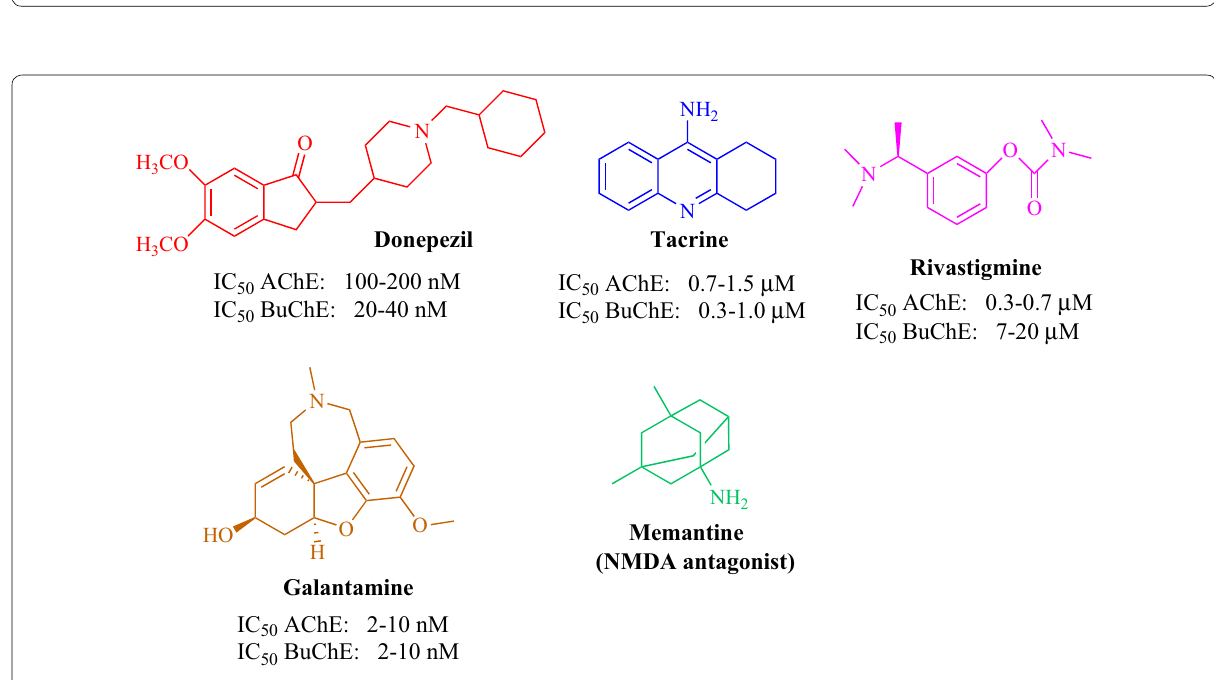
Fig. 35 Interaction of compound C40 docked into the binding site of AChE. The hydrophobic bromo substituent of C40 is oriented toward a hydrophilic pocket of active site [50]